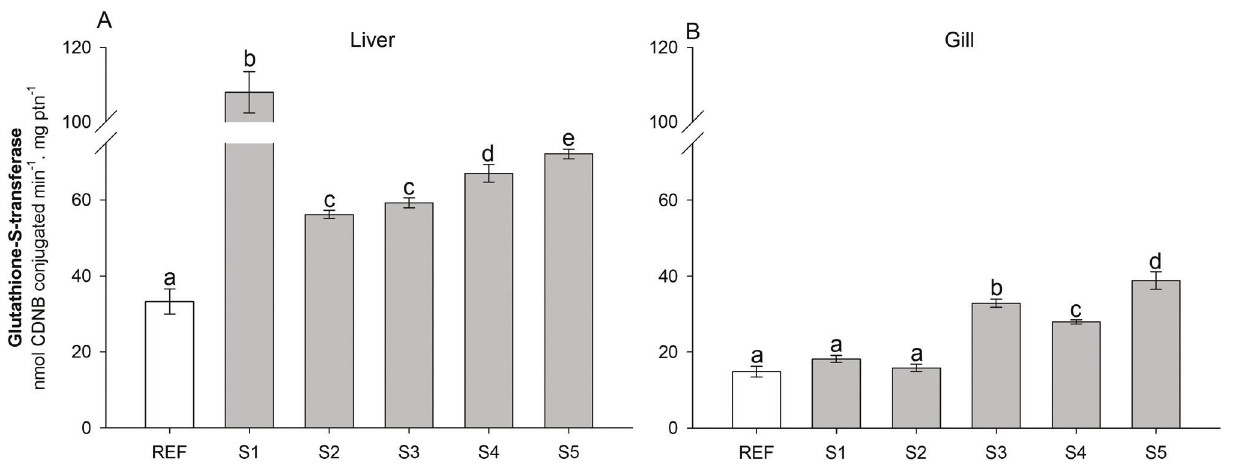
Fig. 2. Activity (mean ± SEM, n = 8) of glutathione S-transferase in liver (A) and gills (B) of A. altiparanae exposed in situ for seven days in five sites along Água das Araras stream (S1, S2, S3, S4, and S5) and in a reference site (Ref). Different letters indicate significant differences between sites (P <